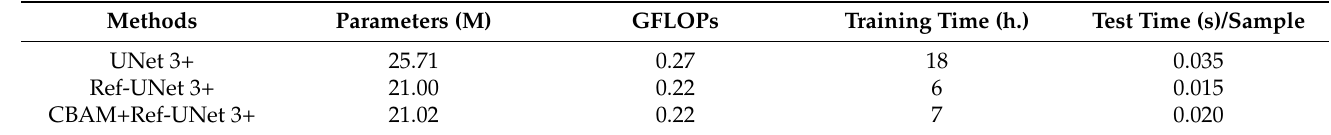
Table 4. Comparison of models in terms of computation